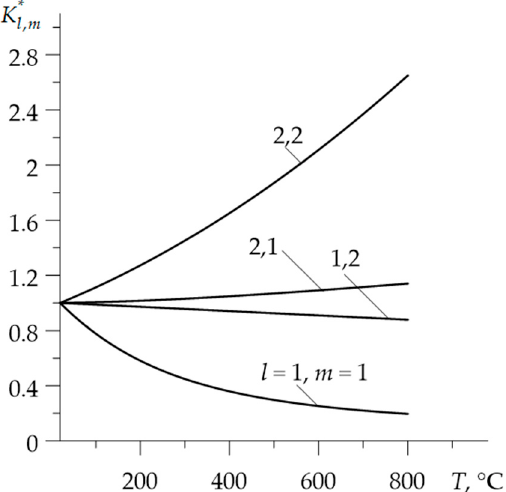
Figure 1. Dependencies of the dimensionless thermal conductivities ∗ K on temperature T . , ml l , m , ml